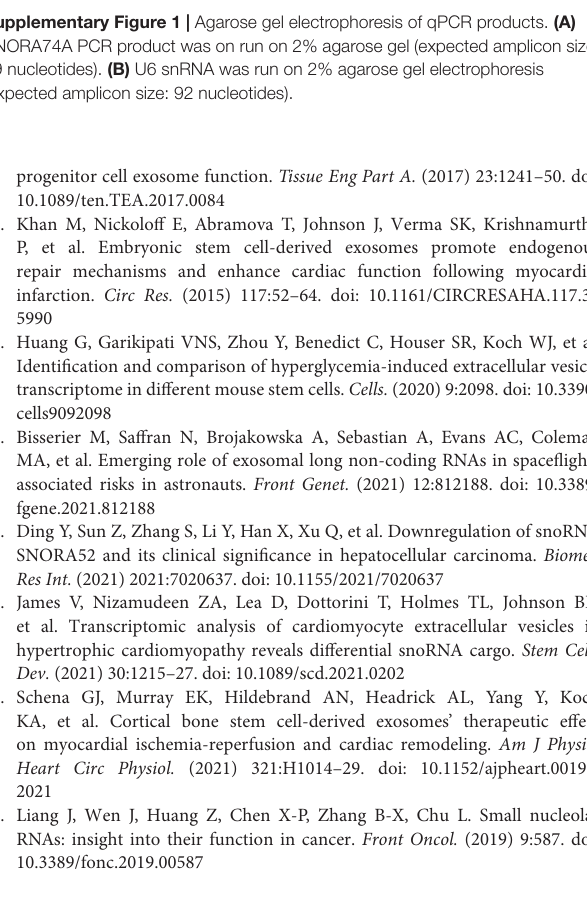
Supplementary Figure 1 | Agarose gel electrophoresis of qPCR products. (A) SNORA74A PCR product was on run on 2% agarose gel (expected amplicon